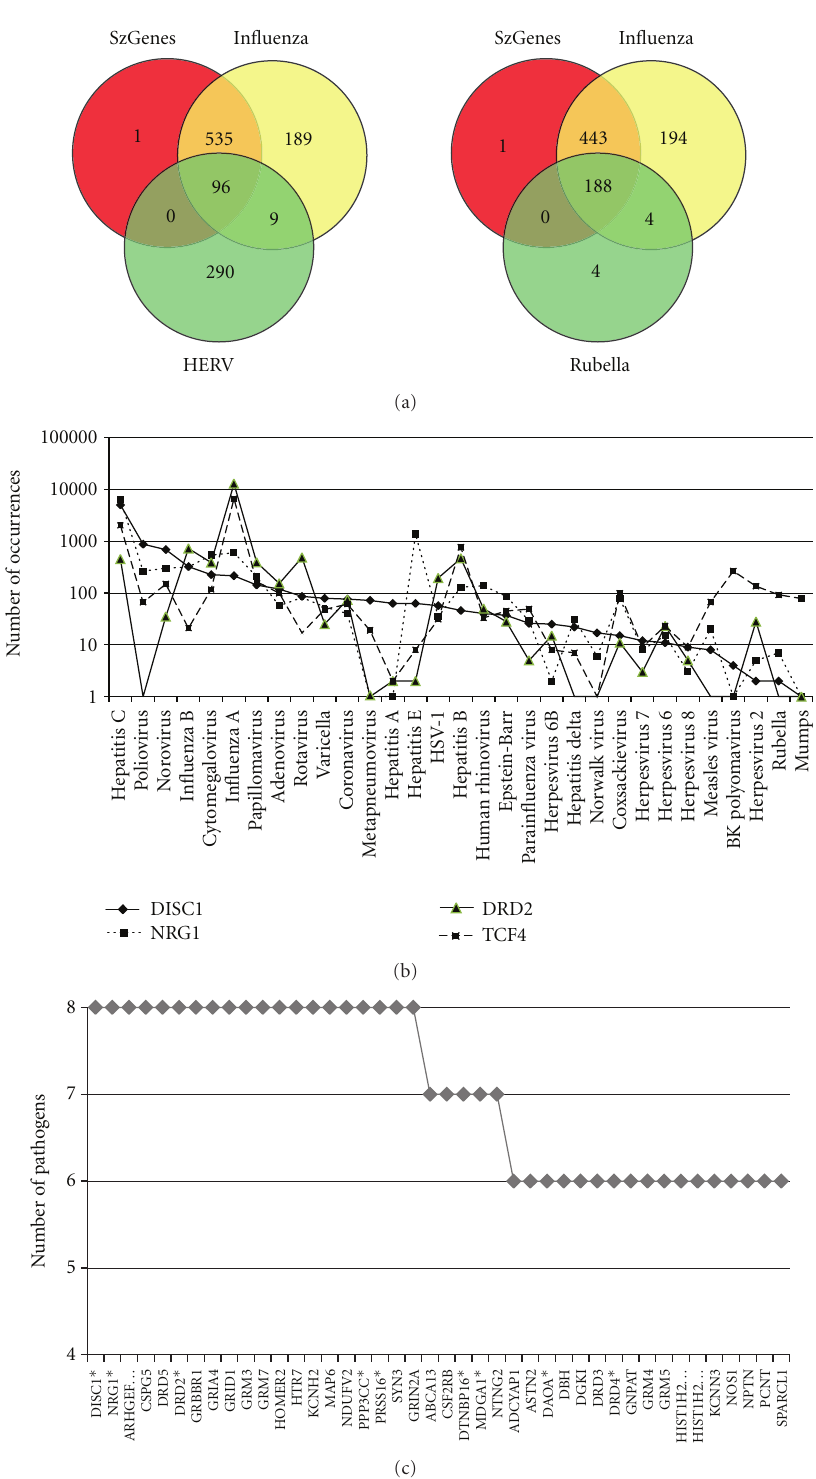
Figure 3: (a) Venn diagrams of the number of Schizophrenia gene products ( N = 632) with homology to the rubella, HERV-W and influenza viruses. The singleton in SZ-genes was di ff erent on each occasion: Thus, all genes are covered. (b) The viral matching spectra of DISC1, neuregulin, the dopamine D2 receptor and transcription factor 4. The Y -axis depicts the number of word occurrences on the original BLAST results page. Note the logarithmic axis. (c) The number of pathogens expressing proteins with homology to the protein products of schizophrenia susceptibility genes. Those marked by an asterisk are within the 30 top-ranked genes in SZ-gene